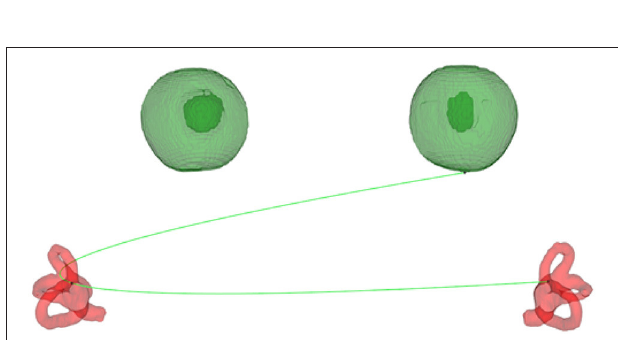
FIGURE 2 | The plane formed by the bifurcation of the common crus and the bottom of the